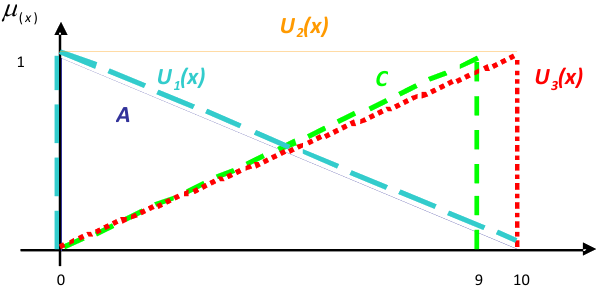
Fig. 7. Comparison of fuzzy numbers A=(0,0,10) and C=(0,9,9) based on descending, constant and ascending linear utility functions